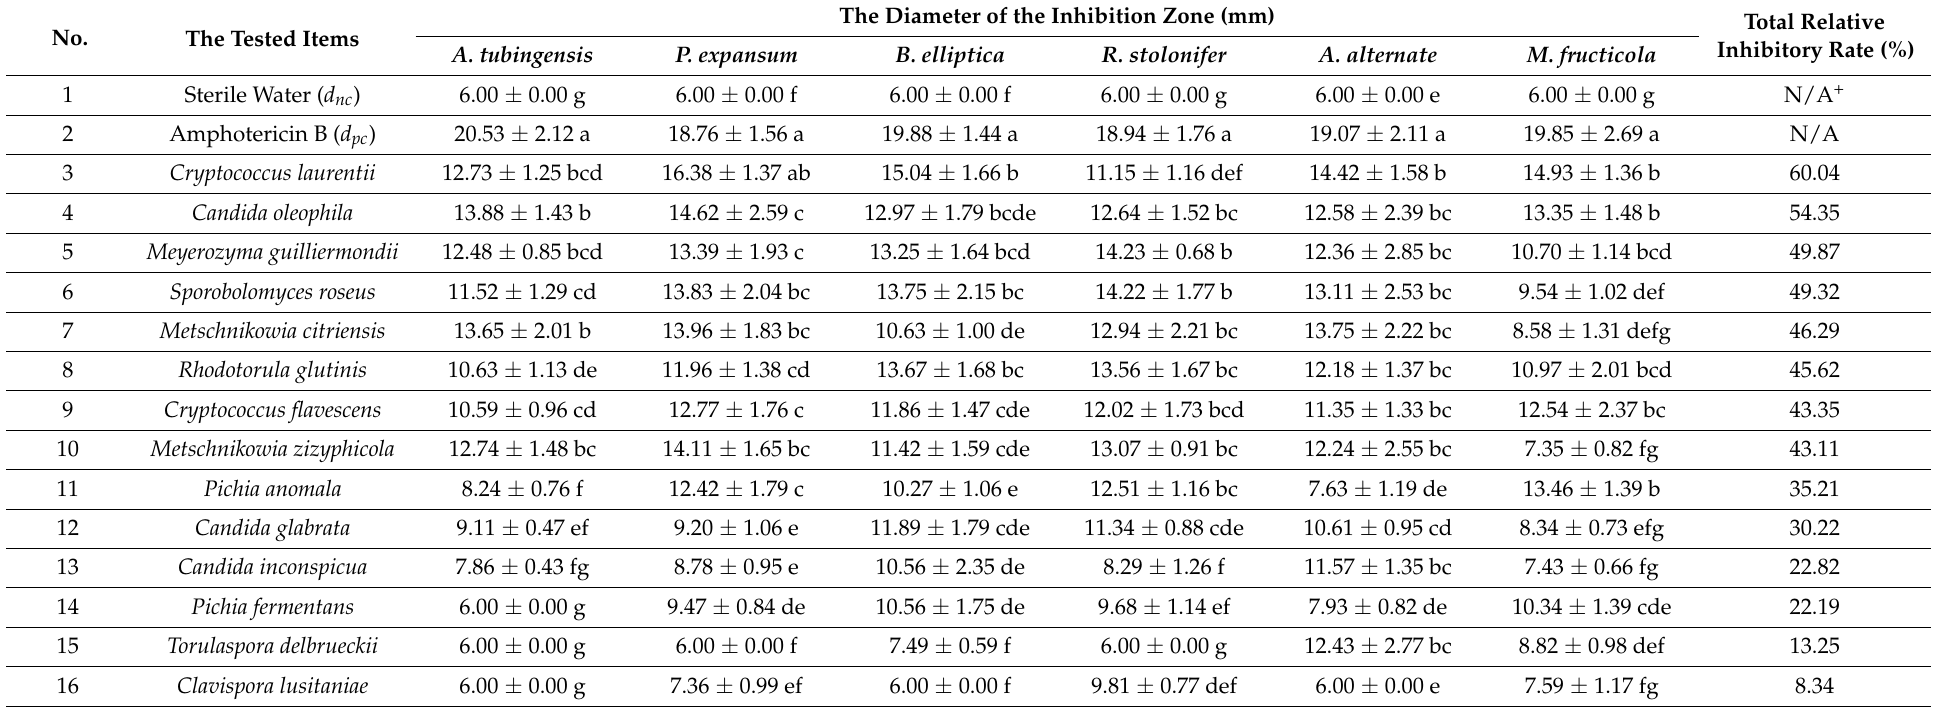
Table 2. The results of inhibition zone with standard